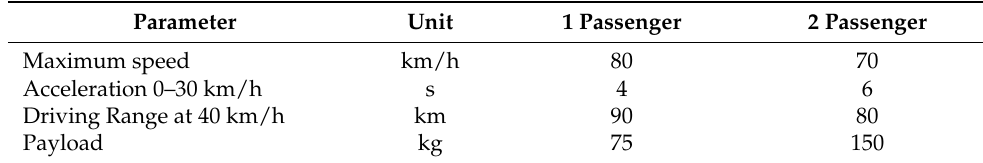
Table 1. Targeted specification of the electric motorcycle.